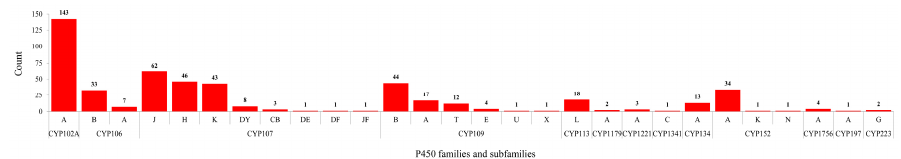
Figure 3. Comparative analysis of P450 families in Bacillus species. The numbers next to the family bar indicate the total number of P450s and percentage contribution (parenthesis) by a respective family to the total number of P450s. The data on the number of P450s in each P450 family in Bacillus species is presented in Table S1.